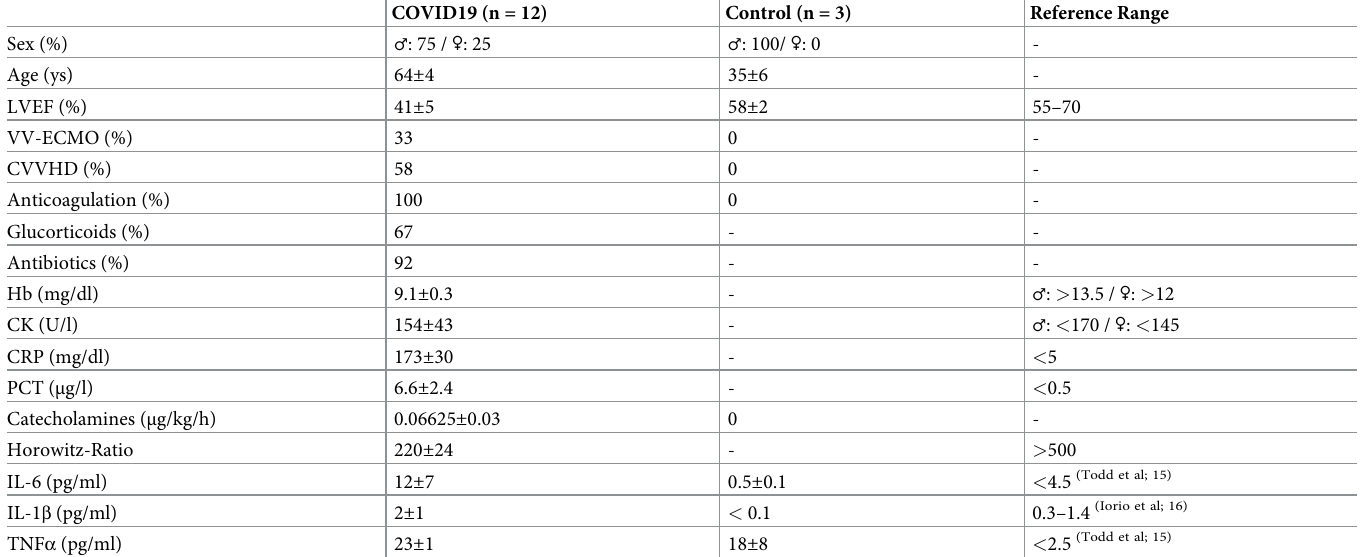
Table 1. Patient characteristics of the study cohort. [15,